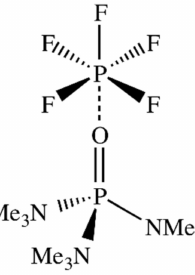
Figure 5. The complex structure between HMPA and PF 5 that may function to prevent thermal